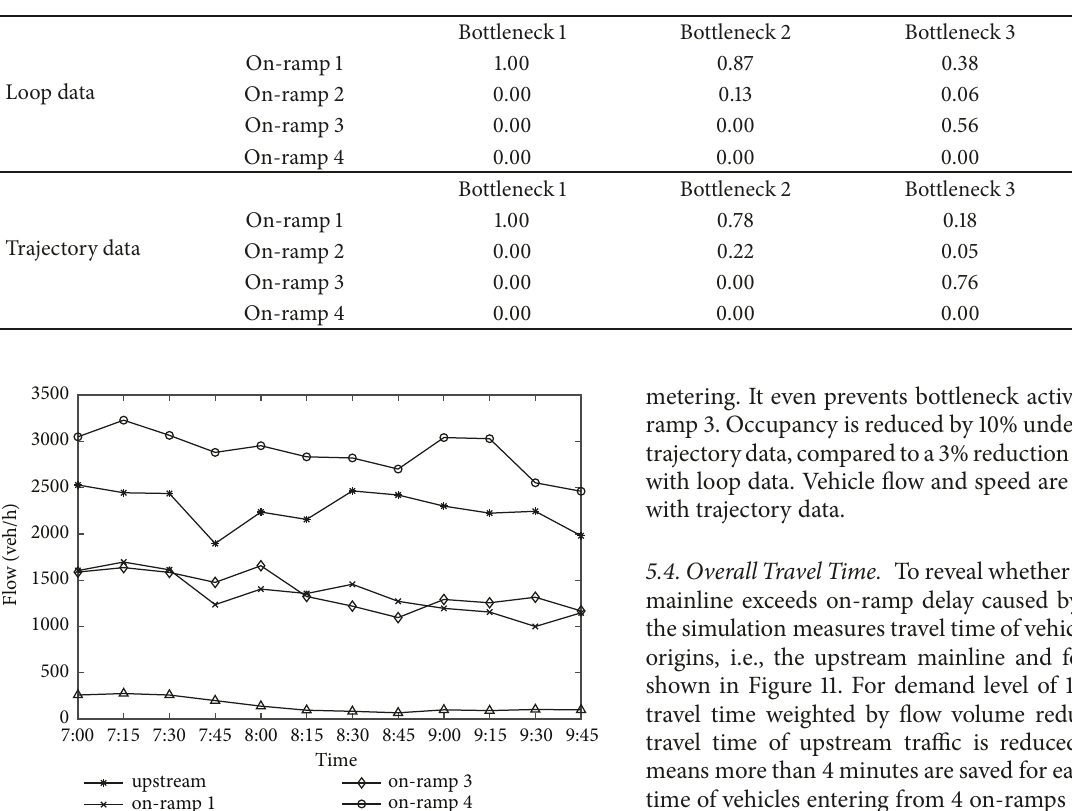
Figure 6: Test site with multiple ramps of North-South Elevated Road (southbound) in Shanghai, China. Table 1: Weights matrix calculated with loop data and trajectory data.